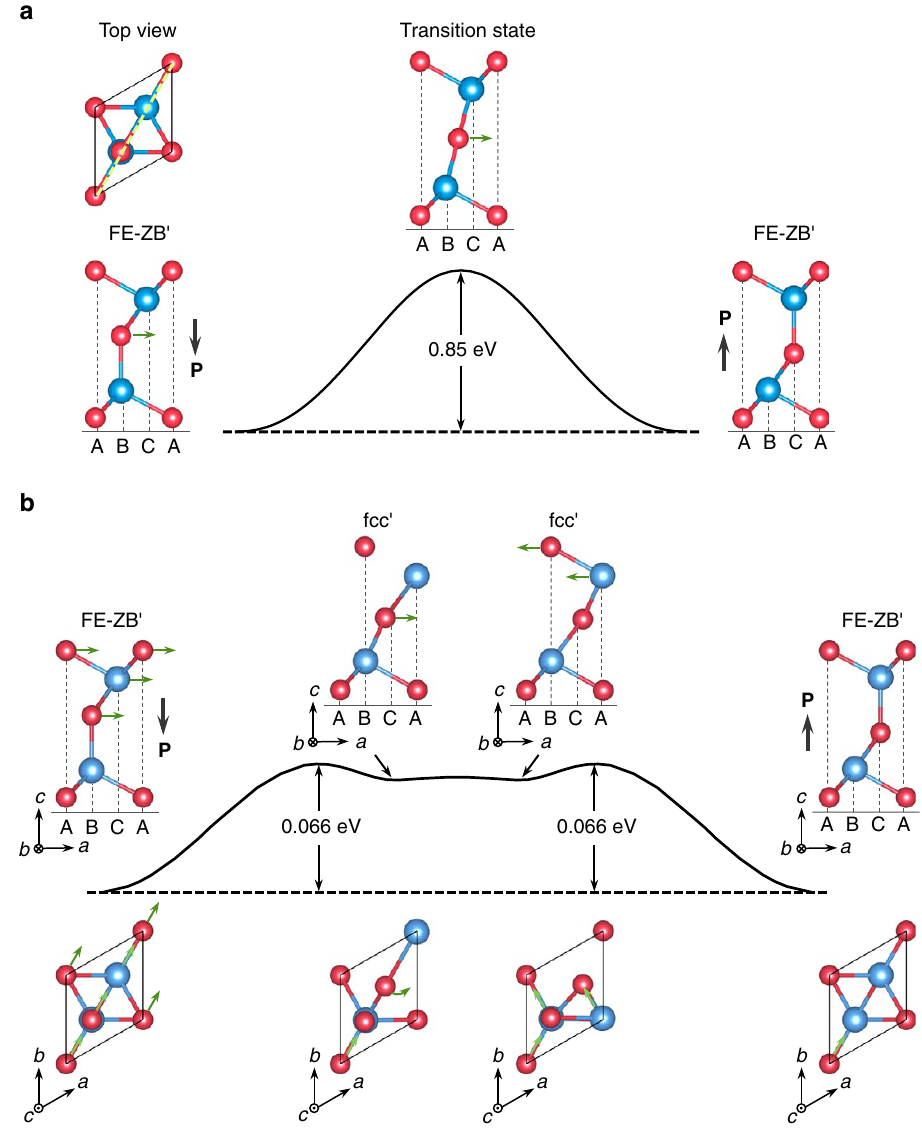
Figure 2 | Kinetics pathways of polarization reversal processes. ( a ) Evolution of the total energy ( y axis) of 1 quintuple layer (QL) In 2 Se 3 in the FE-ZB 0 phase transforming from the state with the electric polarization pointing downward (left) to the state with the electric polarization pointing upward (right) via a direct shifting process: the Se atoms in the central layer laterally shift from the B to C sites. The green arrows attached to atoms indicate the directions of atomic motion during the polarization reversal processes, which are in the plane perpendicular to the In 2 Se 3 layer and passing through the green dashed line as shown in the top view. ( b ) Energy profile of the most effective kinetic pathway to reverse the orientation of the electric polarization of one QL In 2 Se 3 in the FE-ZB 0 phase involving a three-step concerted mechanism, as detailed in the main text. The activation barrier of the concerted motion is lower than the direct shifting process by an order of magnitude (note that the height of the barrier shown in a is scaled down by a factor of